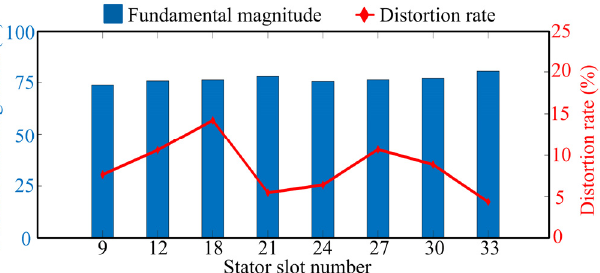
Figure 3. The variation in back EMF with the variation in the number of stator slots when the number of rotor poles is 8.